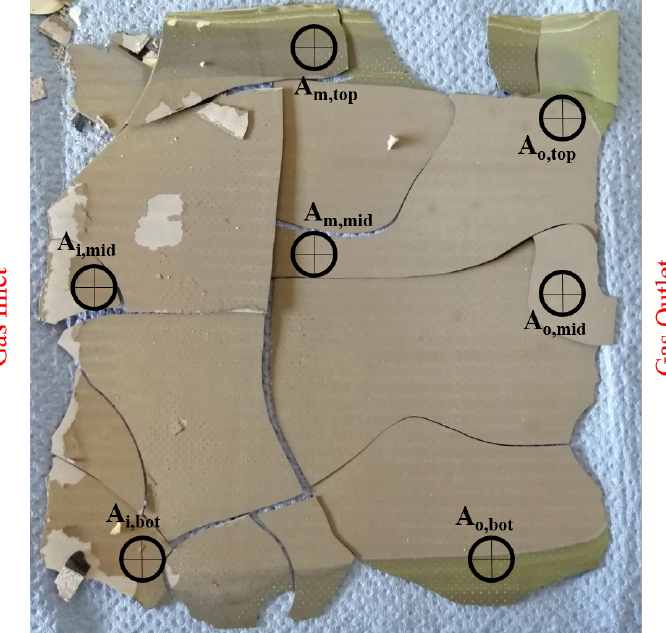
Figure 15. Anode side of the single cell operated for 500 h with Comp.